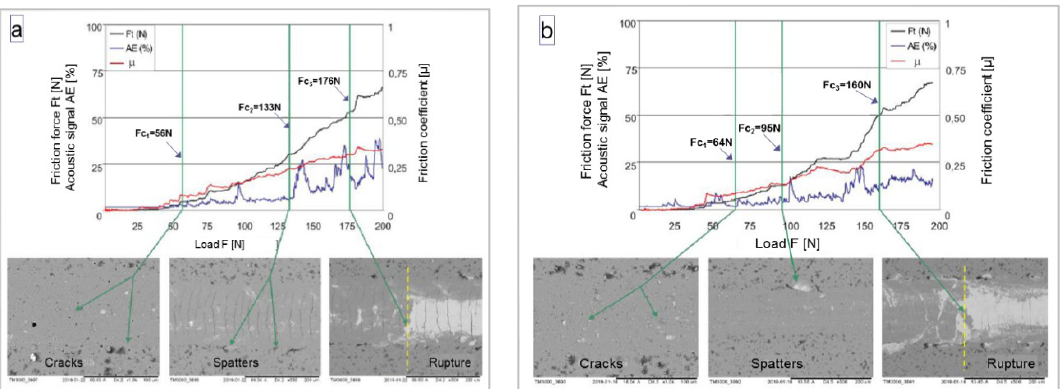
Figure 7. SEM images of paths results of scratch-test accompanied by graphs of friction coe ffi cient, friction force and acoustic emission in relation to applied load for P1 ( a ) and P2 ( b ) coatings.